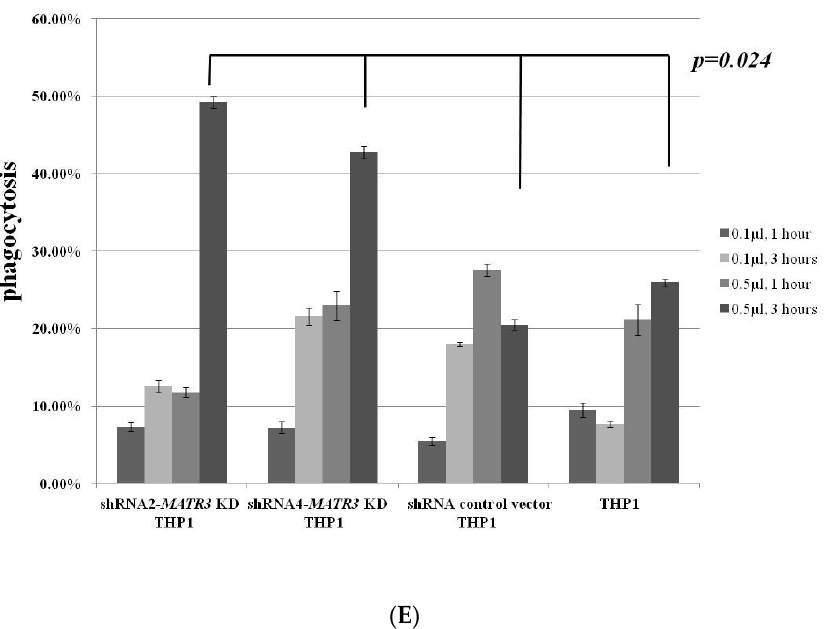
Figure 4. Phagocytosis of ( A ) 0.1 µL carboxylate modified polystyrene latex beads for 1 h and ( B ) 3 h, ( C ) 0.5µL carboxylate modified polystyrene latex beads for 1 h and ( D ) 3 h, in shRNA-MATR3 KD THP1 cells. The shRNA2- and shRNA4-MATR3 KD THP1 cells had a higher percentage of 0.5 µL latex beads phagocytosis in 3 h. The percentage of phagocytosis is PE(+) in THP1 cells (CD33(+) cells). ( E ) a statistic picture.